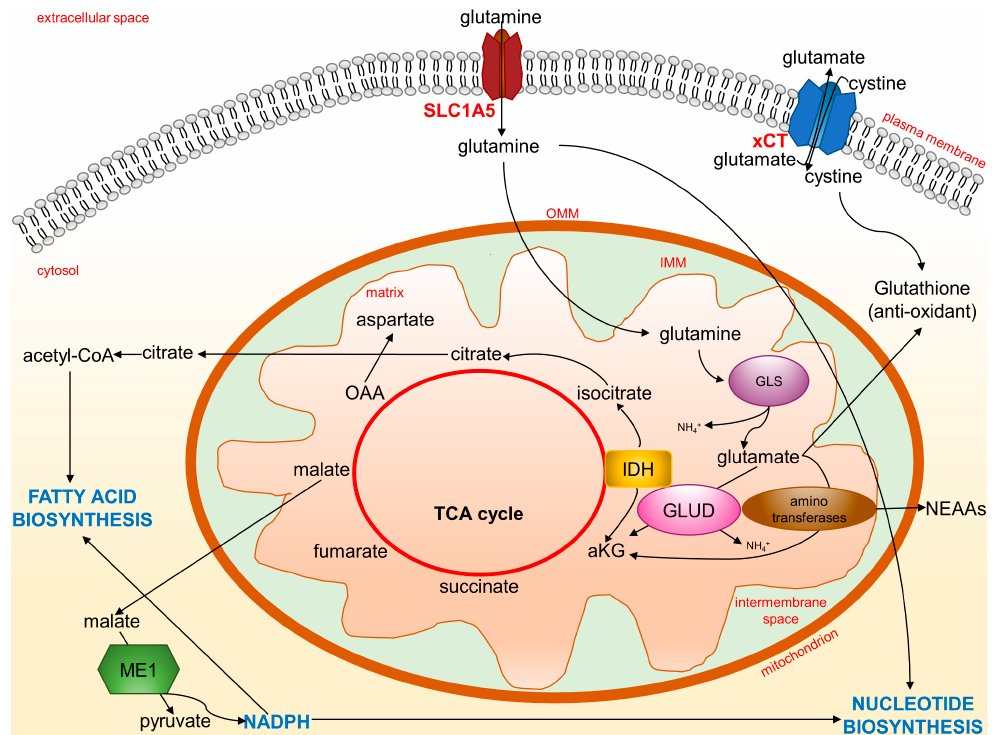
Figure 4. Glutamine and glutamate metabolic fates. Cancer cells rewire their metabolism to sustain fast growth and adapt to oxidative stress. Glutamine entrance and metabolism are enhanced to support new biosynthesis of essential molecules, such as amino acids, nucleotides, and fatty acids, to fuel TCA cycle for energy and to control oxidative stress through glutathione synthesis. aKG: alpha- ketoglutarate; GLS: glutaminase; GLUD: glutamate dehydrogenase; IDH: isocitrate dehydrogenase; IMM: inner mitochondrial membrane; ME1: malic enzyme; NEAA: non-essential amino acids; OAA: oxaloacetic acid; OMM: outer mitochondrial membrane; TCA cycle: tricarboxylic acid cycle; xCT: glutamate-cystine antiporter.